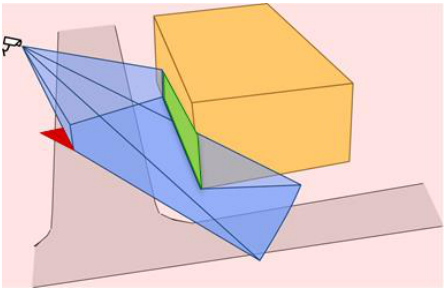
Figure 4 FOV analysis of individual CCTV